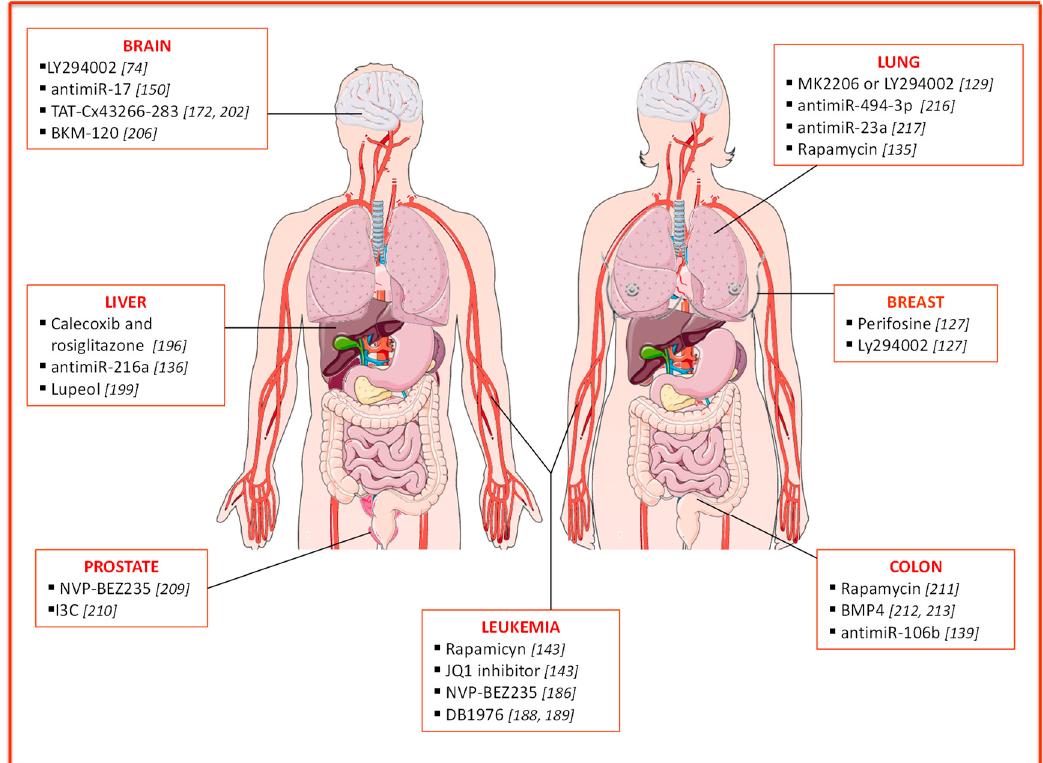
Figure 2. Targeting PI3K/ PTEN /Akt/mTOR pathways for cancer